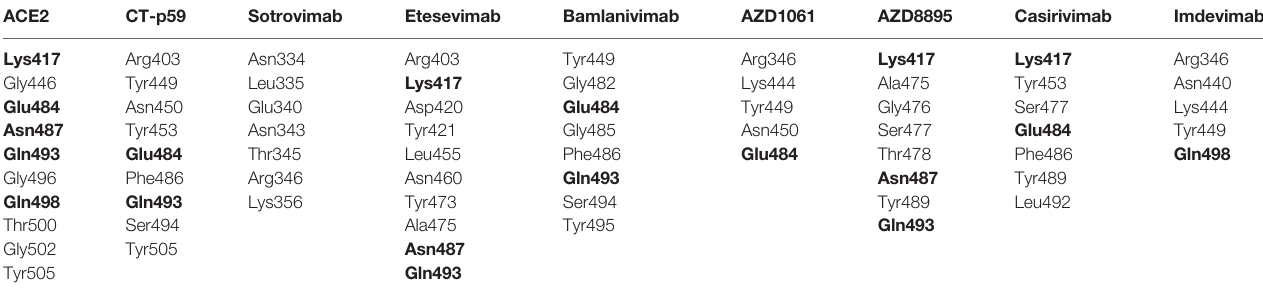
Bold residues are shared by ACE2 and mAbs on the RBD interface.